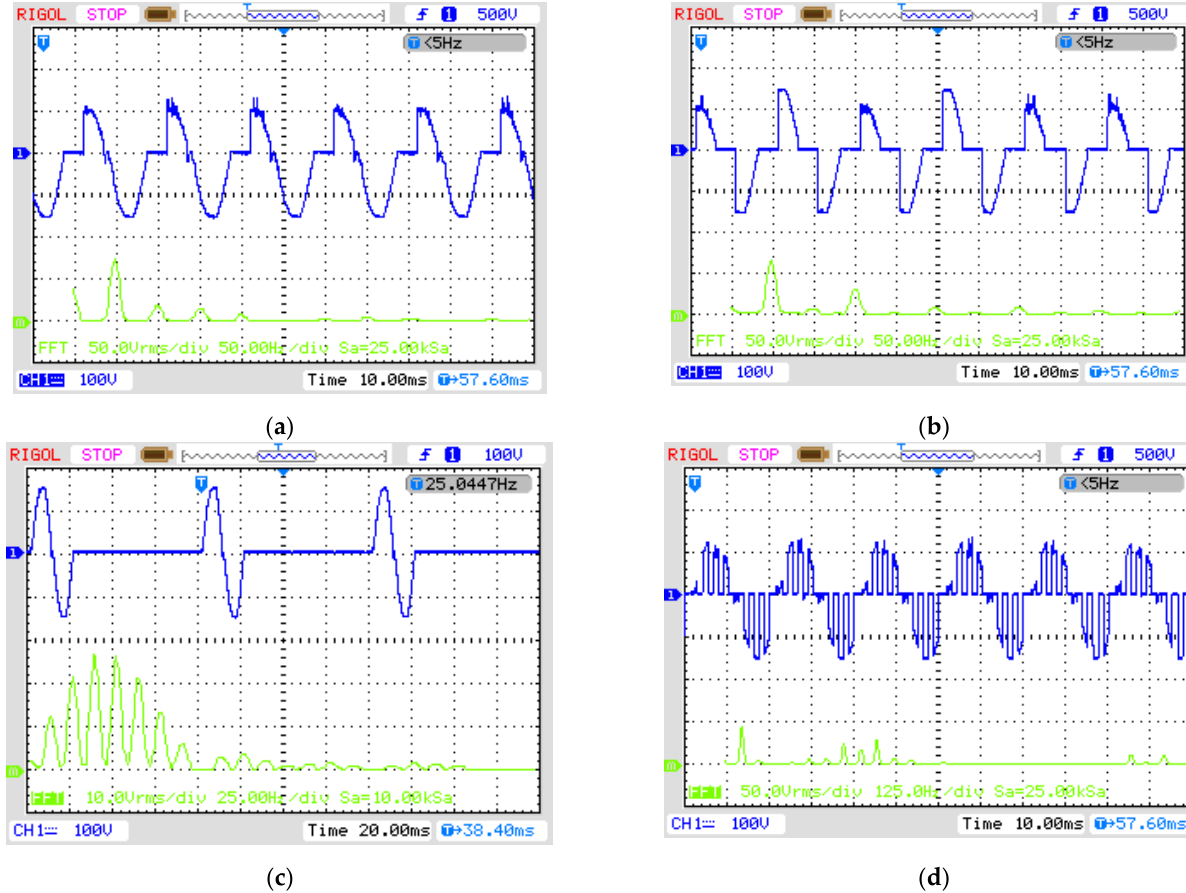
Figure 20. RMS voltage control at the output through ( a ) phase angle half-wave control; ( b ) phase angle full-wave control; ( c ) a number of on-off cycles control; ( d ) PWM control.